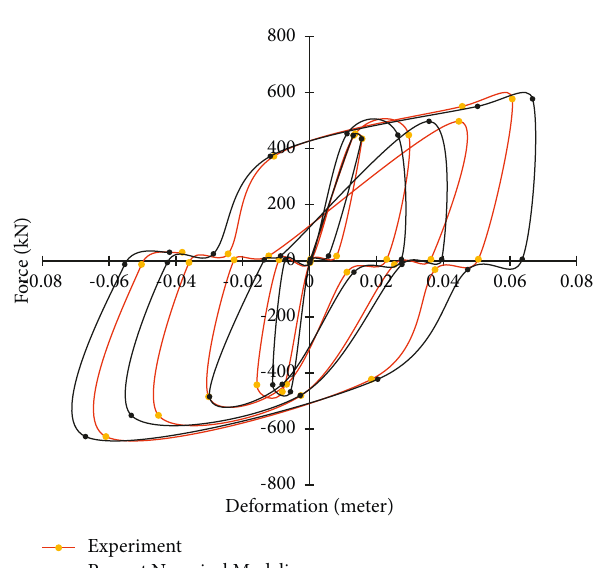
Figure 12: Cyclic experimental and numerical results of the TS- BRB frame.